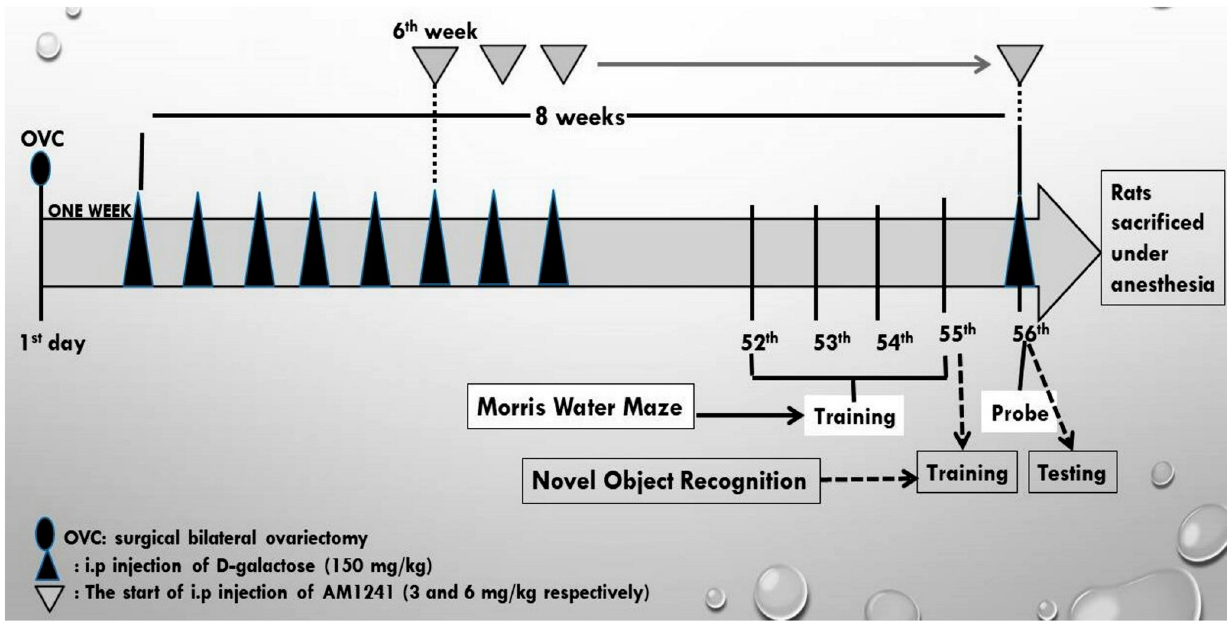
Fig 1. The schematic presentation of the experimental